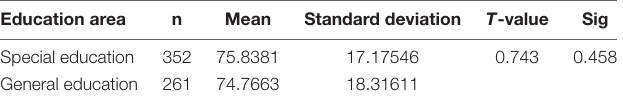
TABLE 8 | T -test: differences among the participants based on current teaching position. Education